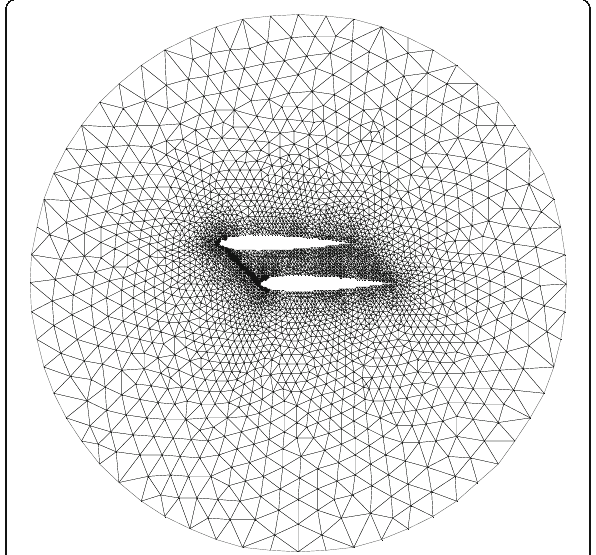
Fig. 11 Double airfoils: smoothed